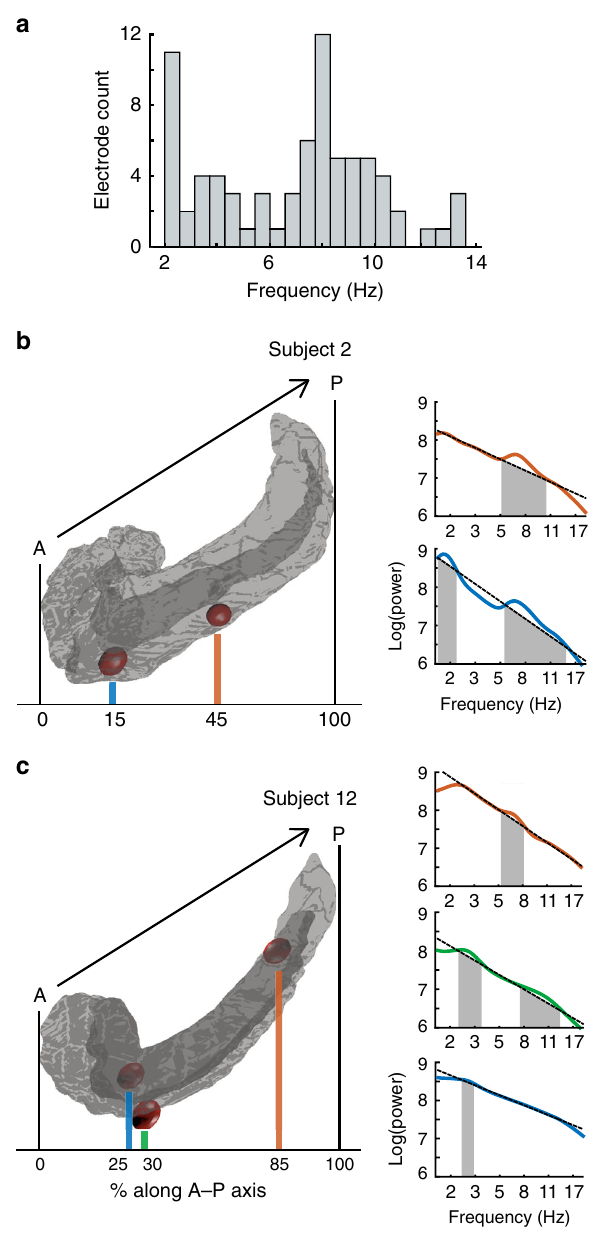
Fig. 2 Power spectra of electrodes along the anterior – posterior axis of the hippocampus. a The distribution of detected oscillations across all hippocampal electrodes in our data set. b Rendering of Subject 2 ’ s left hippocampus (left) and the power spectra (right) for electrodes implanted in this area. Shading in the power spectrum indicates detected narrowband oscillations. c Rendering of Subject 12 ’ s left hippocampus and power spectra for the implanted